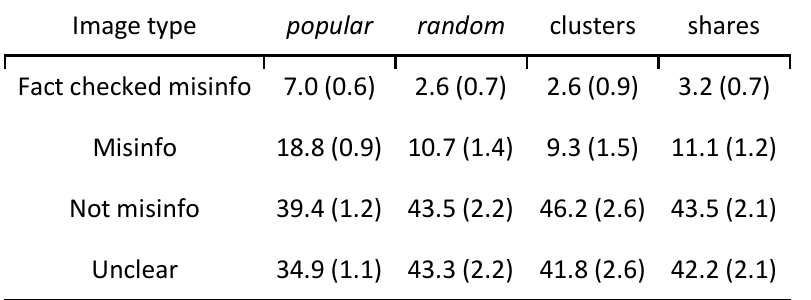
Finding 2: Most image misinformation falls into three categories: old images taken out of context, memes and photoshopped